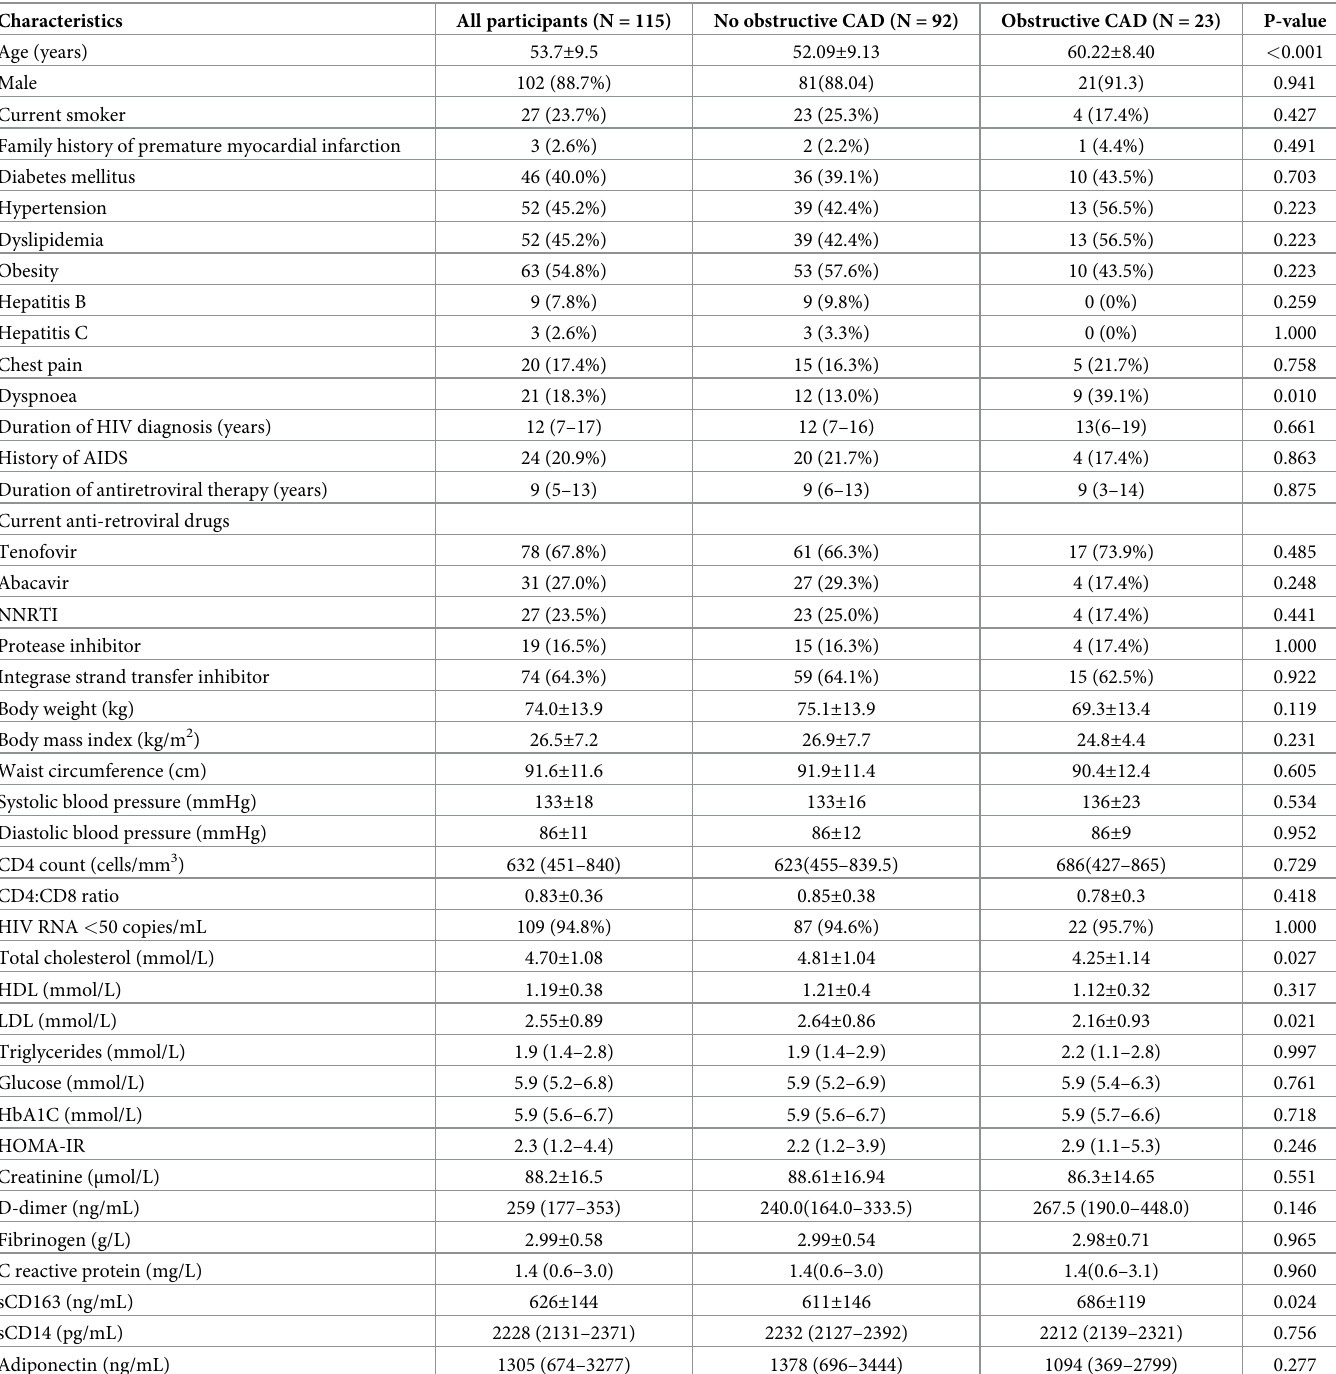
Table 2. Demographic and clinical characteristics in participants with and without obstructive coronary artery disease (CAD) # .